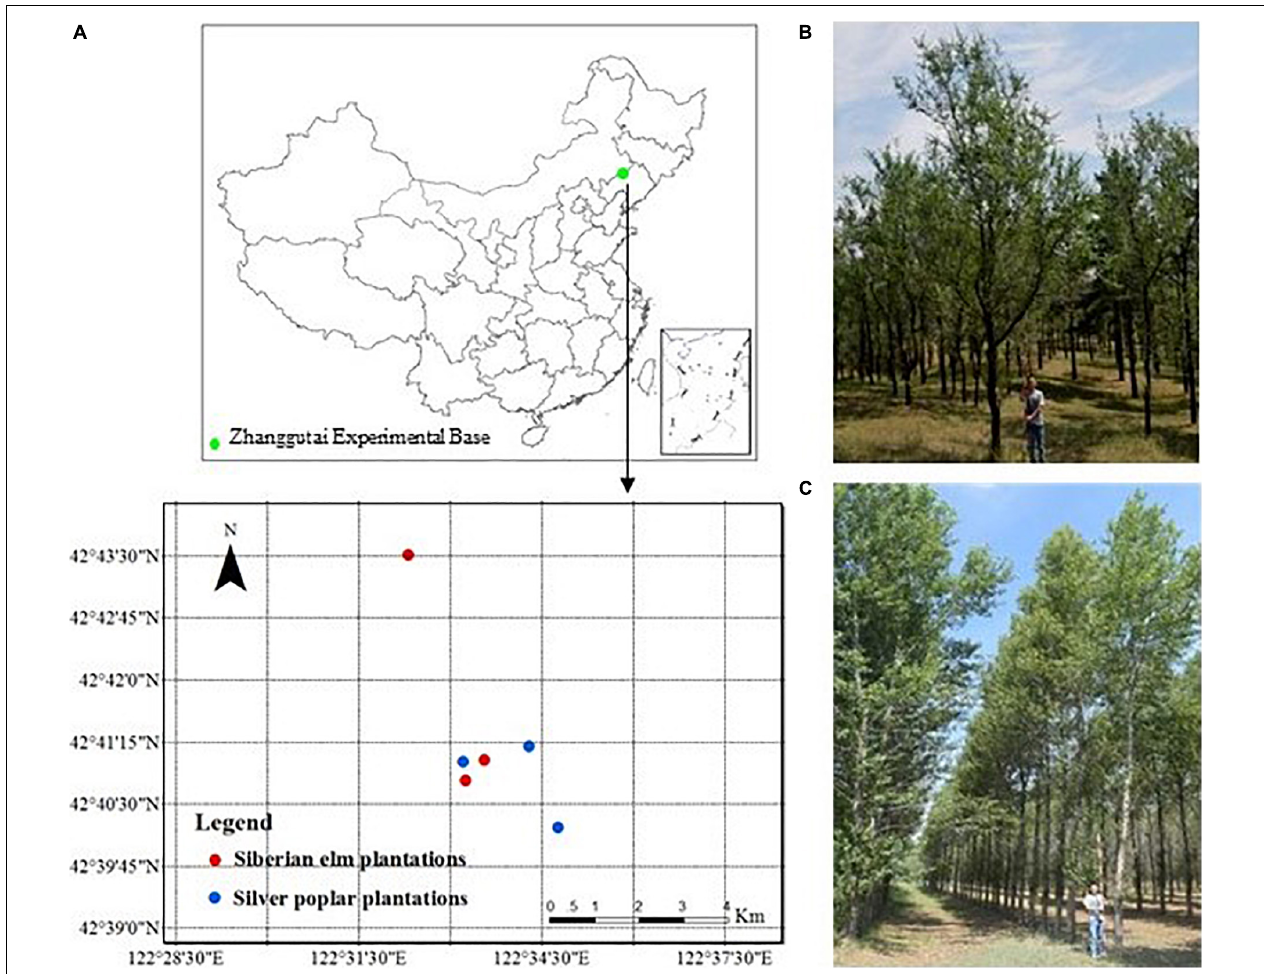
FIGURE 1 | Location of the study area (A) and photos of the Siberian elm (B) and Silver poplar (C) plantations.